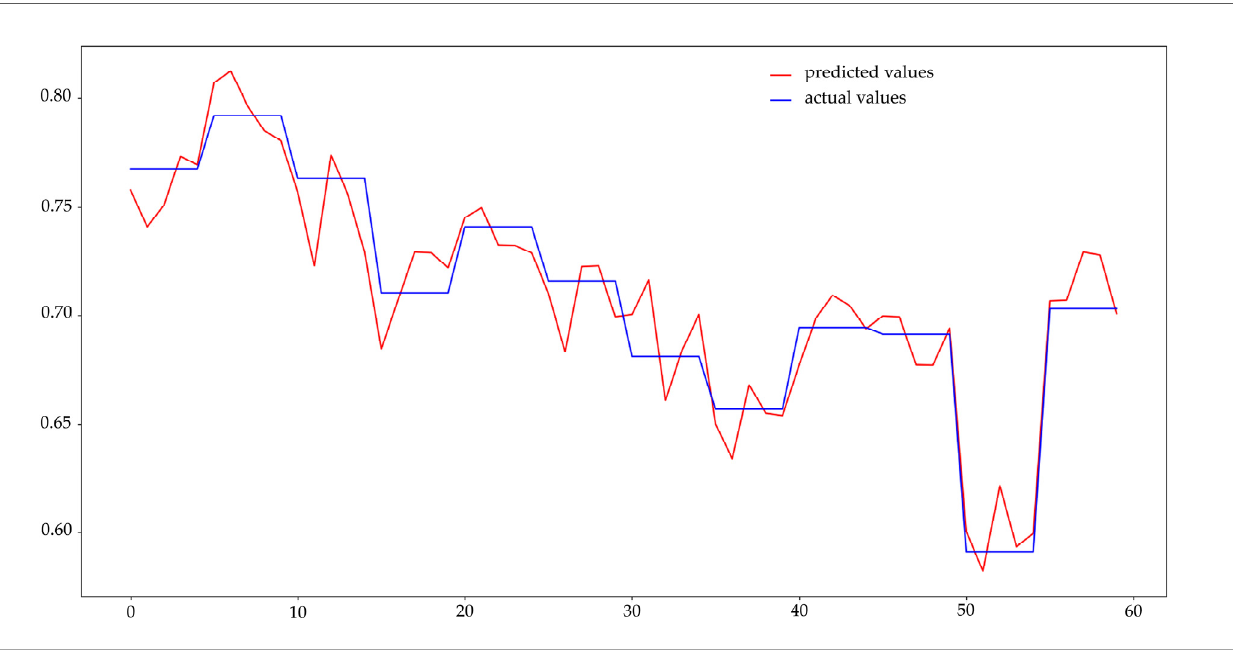
Figure 13. Actual values and values predicted by the ANFIS model—bell-shaped function.